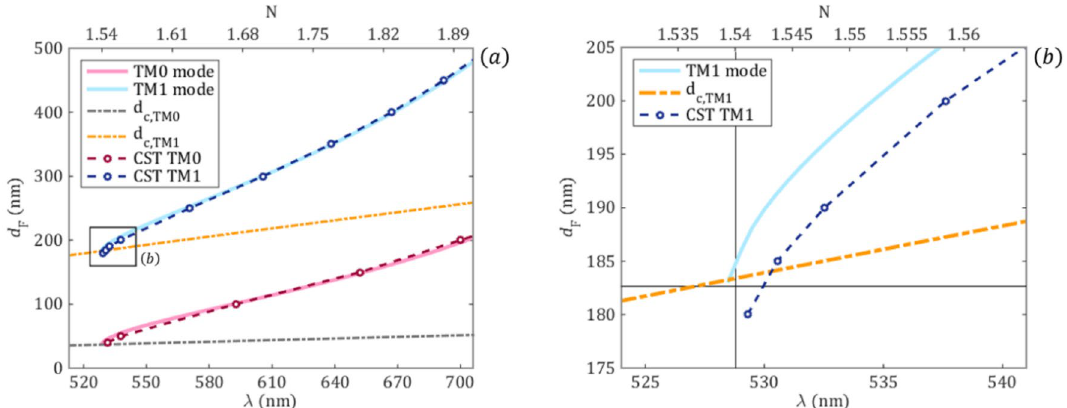
Figure 3. ( a ) TM 0 and TM 1 mode curves calculated with the 3-layer model (continuous lines) and the numerical electromagnetic simulations (open circles) with an incidence angle of 26°. The graph shows the waveguide thicknesses as function of the corresponding illumination wavelength and effective refractive index when the cover refractive index is n C = 1.4 . The dashed lines are the thicknesses corresponding to the cut-off wavelengths. ( b ) Magnification of the TM 1 curve near the cut-off point. The black vertical line is located at N = n S = 1.54 , which is the cut-off